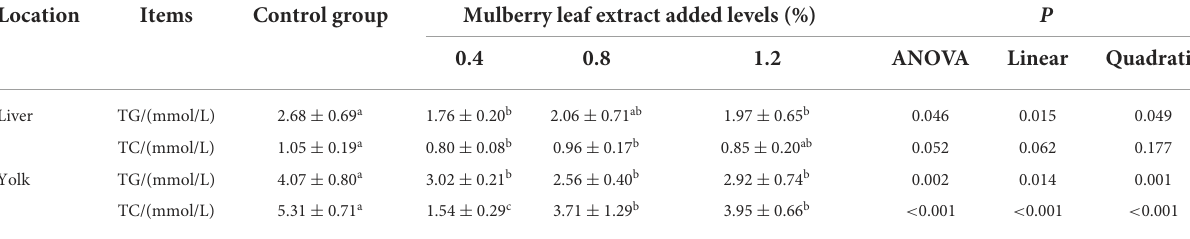
TABLE 6 Effects of mulberry leaf extract on lipid metabolism parameters of laying hens.